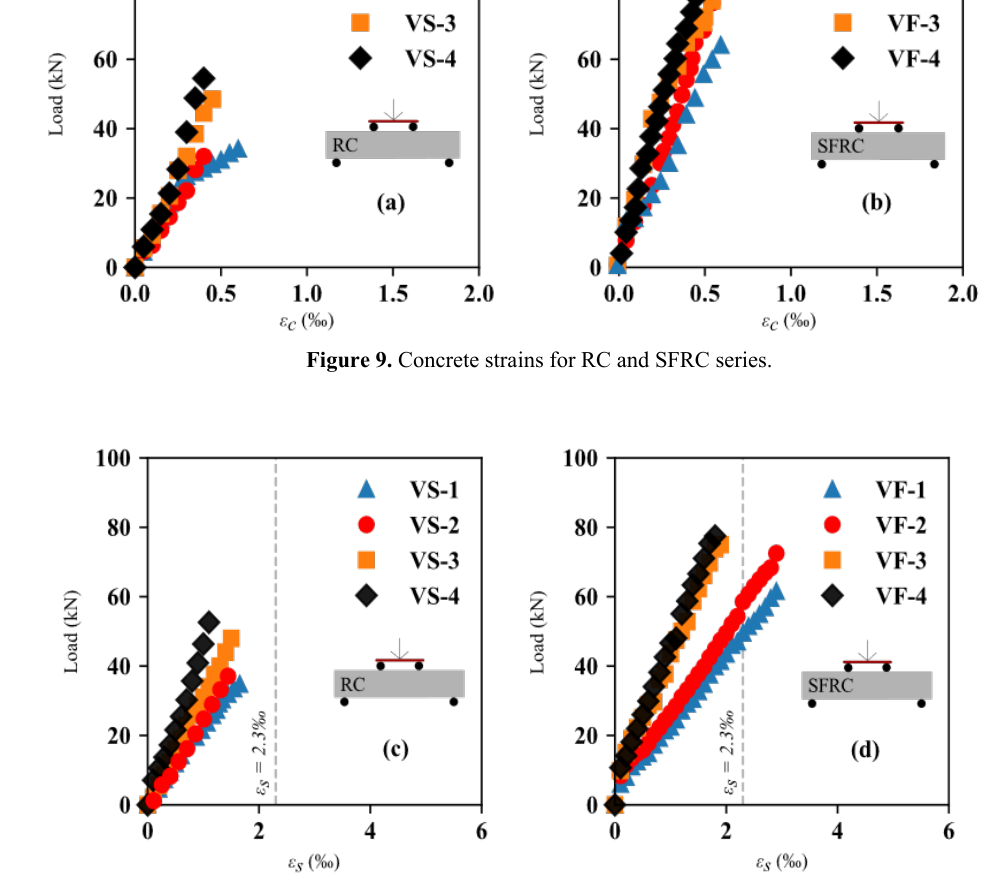
Figure 10. Strains in the longitudinal reinforcement for RC and SFRC